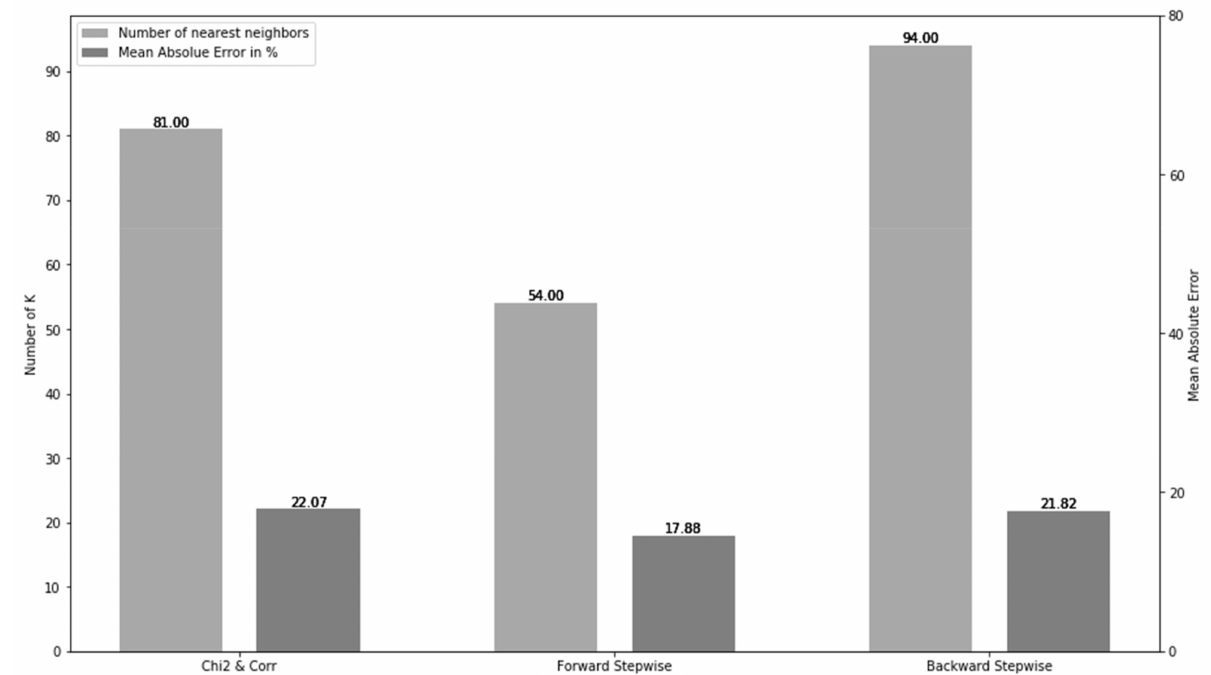
Figure 4. The number of nearest neighbors and mean absolute